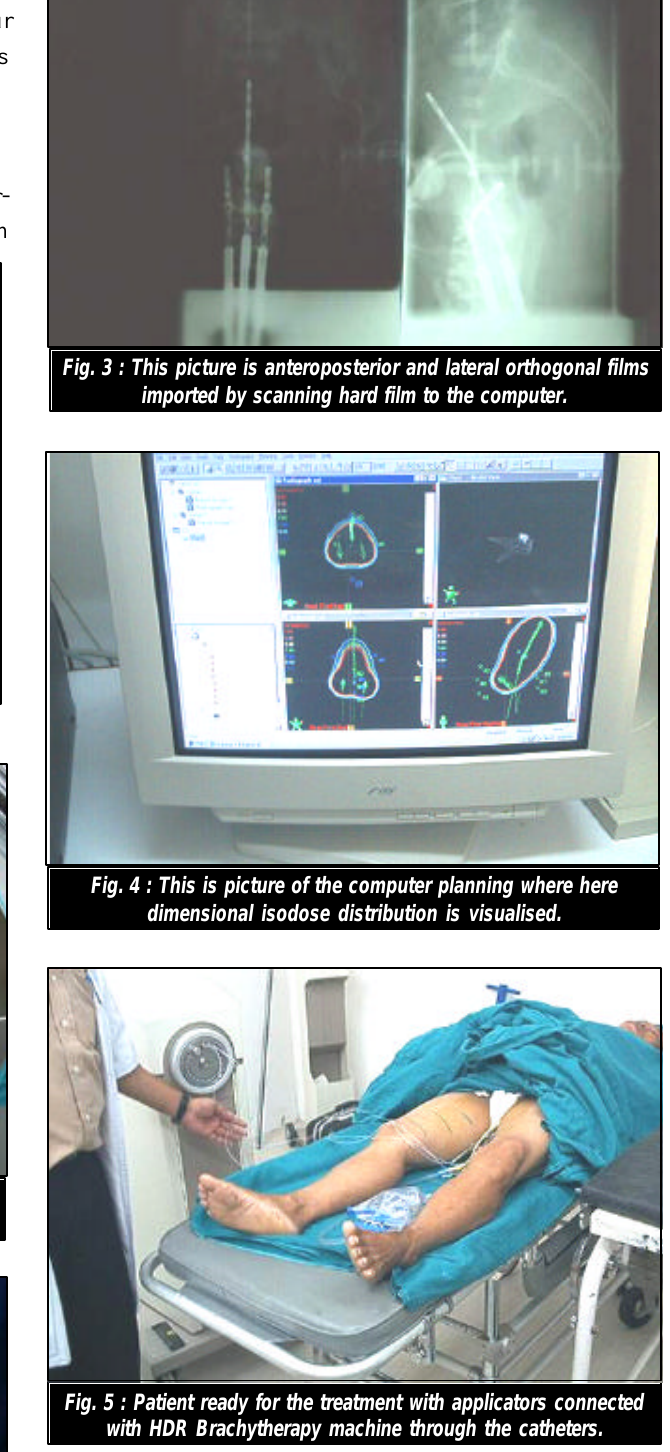
Fig. 5 : Patient ready for the treatment with applicators connected with HDR Brachytherapy machine through the